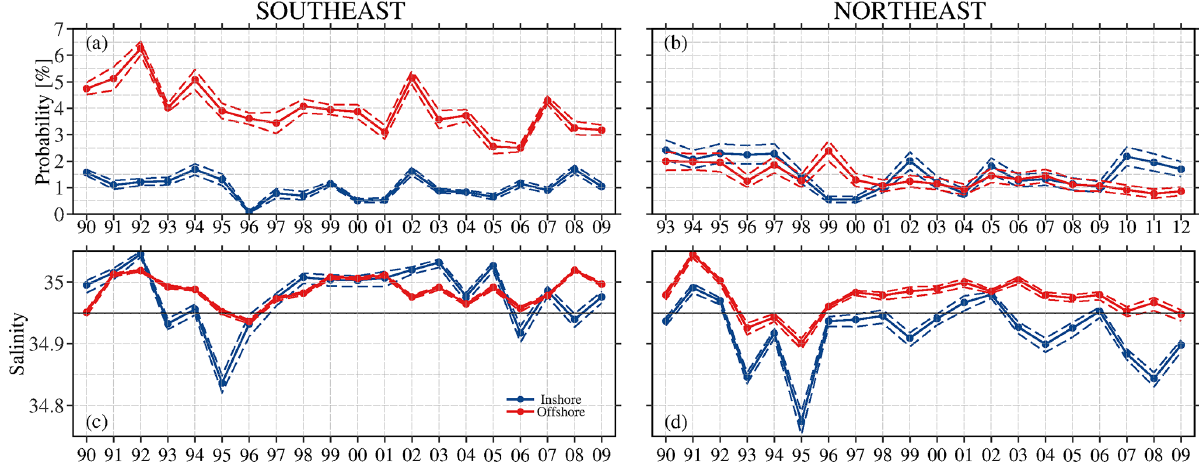
Figure 9. The probability of water entering the basin in the (a) northeast and (b) southeast. The salinities of particles crossing in (c) the northeast and (d) the southeast. The colors refer to the water’s origin: blue shows the EGC inshore water, red the EGC offshore water. The doted lines show the estimated